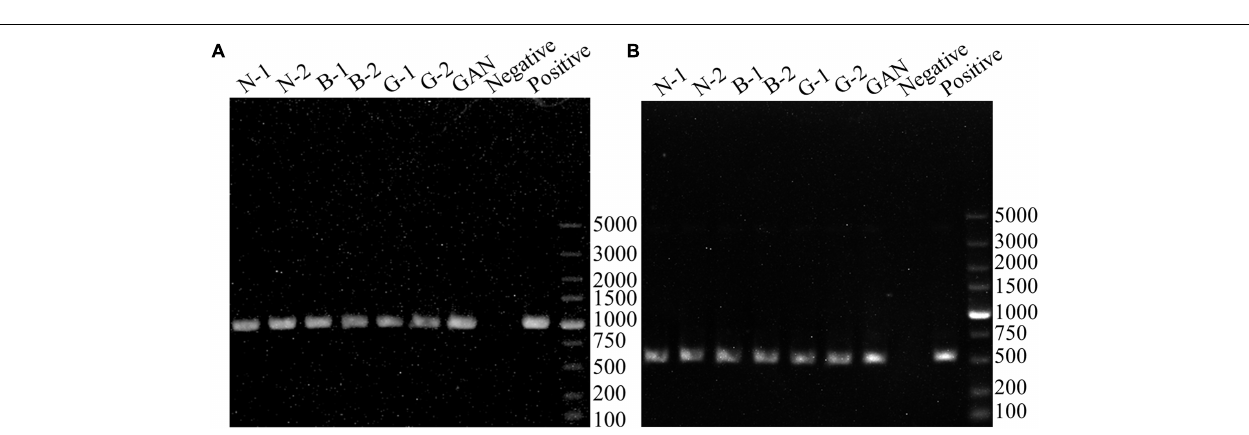
FIGURE 2 | PCR results for the genes involved in BAs production. (A) PCR products using the primer pair TD2/TD5 for identification of tyrosine decarboxylase gene. (B) PCR products using the primer pair ODF/ODR for identification of ornithine decarboxylase gene. PCR positive controls ( Enterococcus faecium DU-1 for tyrosine decarboxylase gene and Oenococcus oeni BJ for ornithine decarboxylase gene).